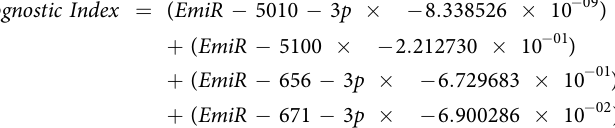
The prognostic index was applied to all TNM-stage II colon cancer patients in the HDH-CC cohort and TCGA-COAD cohort. ROC-curve analyses were performed in order to generate the best cut-point of the prog- nostic index with optimal sensitivity and specificity at which low-risk patients can be distinguished from high-risk patients. The area under curve (AUC) in the ROC analyses for the HDH-CC and TCGA-COAD cohorts were statistically significant (AUC = 0.901, 95% CI: 0.75–1.00; P = 0.001; Fig. 1A and AUC = 0.658, 95% CI: 0.53–0.78; P = 0.0.19; Fig. 1B, respectively). Eighty percent of the patients in the HDH-CC cohort and 64% of the patients in the TCGA-COAD cohort have a low risk of recurrence, according to our four-miRNA classifier (Table 1). We did not observe any statically significant associations between the level of the classifier and other clinicopathological features in the HDH-CC and TCGA-COAD cohort (Table 1).